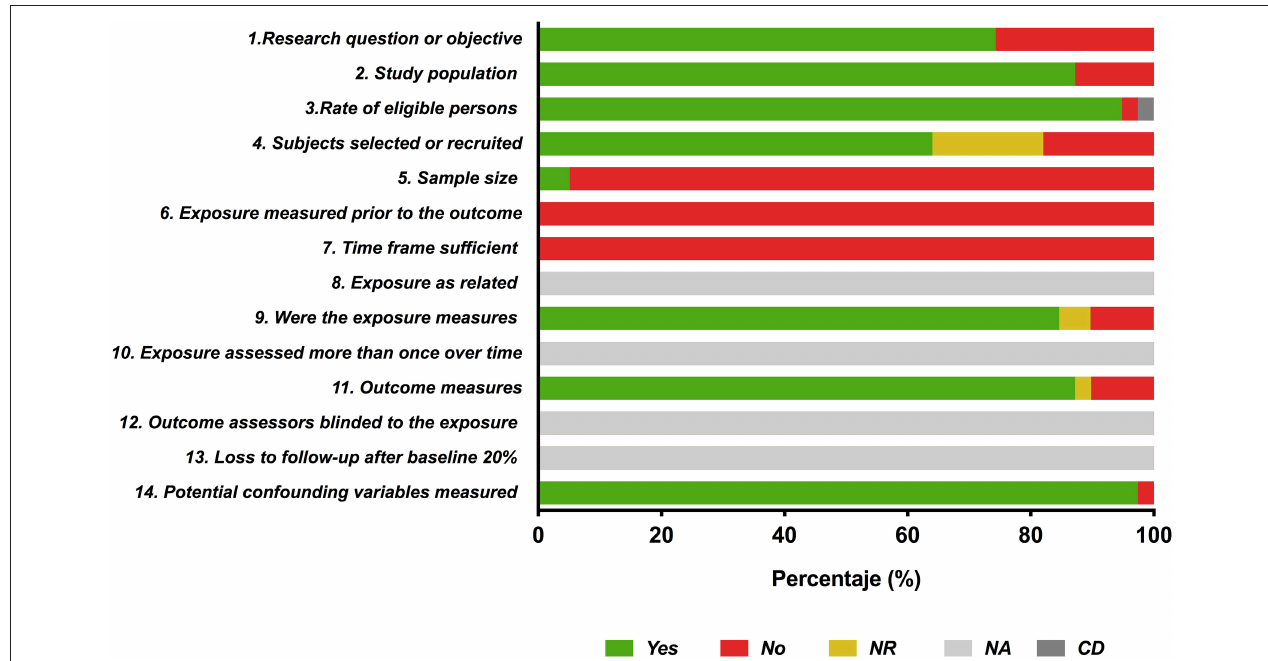
FIGURE 2 | Report of the study quality index components in the included studies. Yes (green bar), No (red bar) NR (yellow bar): not reported; NA (light gray bar): not applicable; CD (dark gray bar): cannot